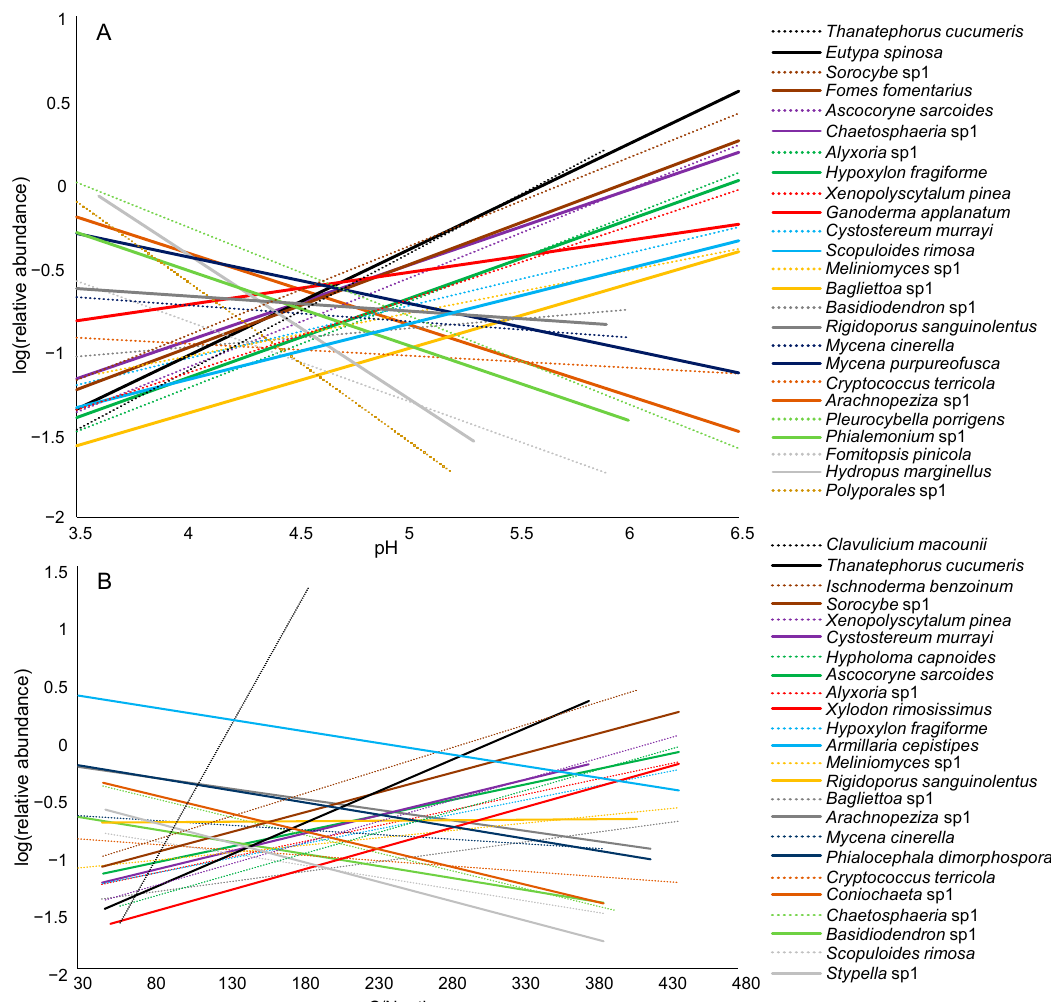
Figure 5. Linear fits of the relative abundances of dominant fungal taxa in the Salajka natural forest and environmental factors for those taxa significantly affected by pH ( A ) and by the C/N ratio ( B ).